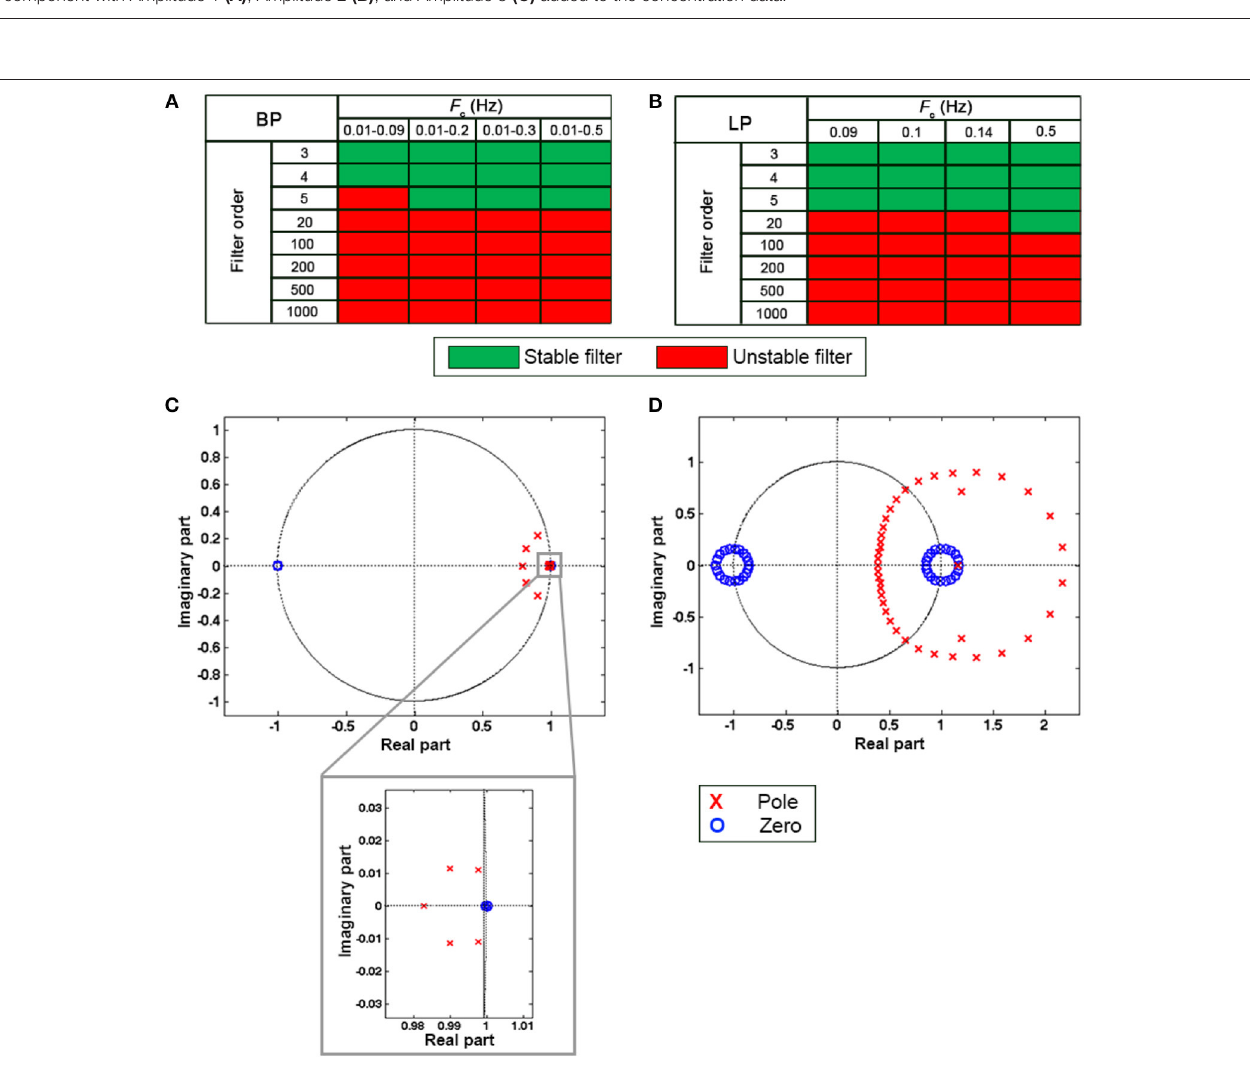
Frontiers in Human Neuroscience |